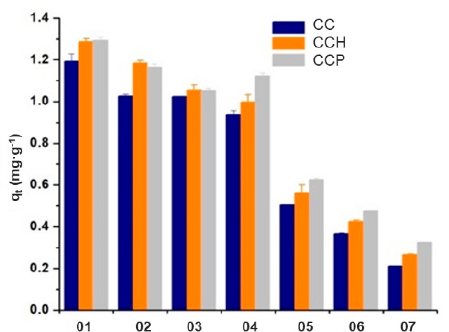
Figure 12. Removal capacities of the synthesized copolymers, with different of 4-vinylpyridine (4VP)/ acrylamide (AAm) co-monomer ratios in their structures.